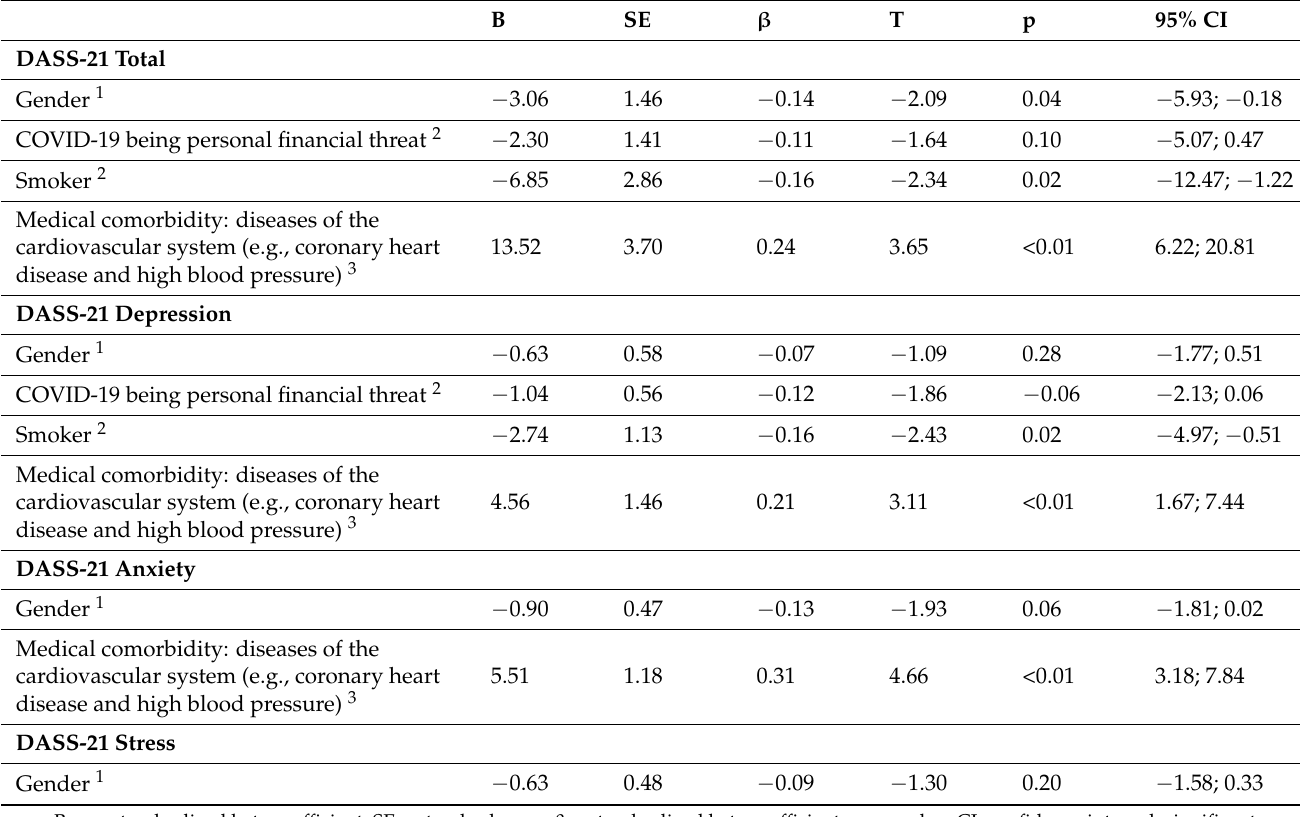
Table 6. Multiple regression analyses with relevant factors of DASS-21 total and subscores.